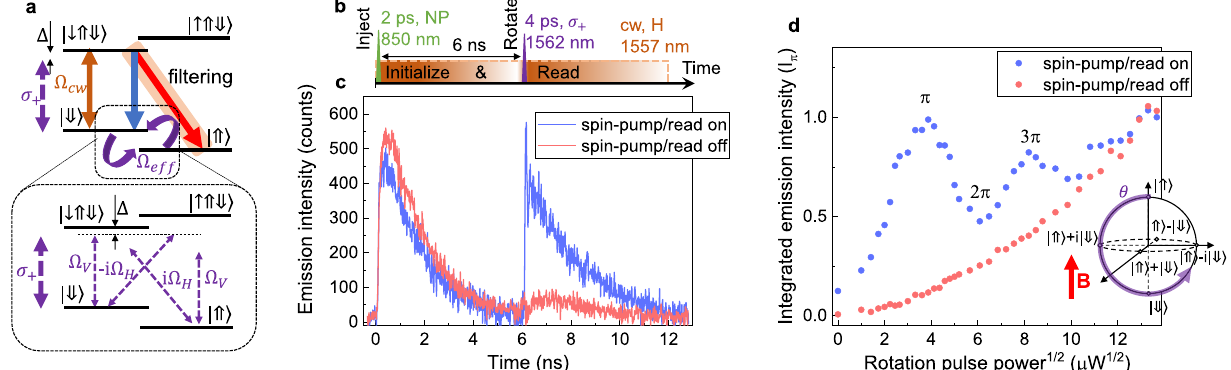
Fig. 4 Optical coherent control of spin. a Trion level structure in Voigt magnetic fi eld geometry with transitions relevant for the spin-initialization, rotation, and read-out. Inset: For the spin rotation a stimulated Raman transition using circularly polarized pulses is used which in case of small detuning can be effectively reduced to spin-rotation of a two-level system. b Pulse sequence used to coherently rotate the spin. The fi rst pulse injects the charge into the (cid:1) (cid:3) (cid:1) QD and a cw spin-pumping laser initializes the spin into the * state. After 6 ns a circularly polarized Raman spin-rotation pulse is applied detuned by (cid:1) (cid:3) (cid:1) state, the cw laser excites the system into #*+ ~400 GHz from the trion transition. Immediately after spin-rotation into the + (cid:1) (cid:1) (cid:3) (cid:3) (cid:1) (cid:1) - * transition in the presence and absence of the cw spin-pumping/read-out laser. d Emission intensity after the spin- c Emission time trace of the #*+ rotation pulse as a function of the square root of the rotation pulse power. Clear Rabi oscillations are visible up to 3 π demonstrating coherent control. Inset: Bloch sphere representation of the hole qubit evolution with the rotation pulse